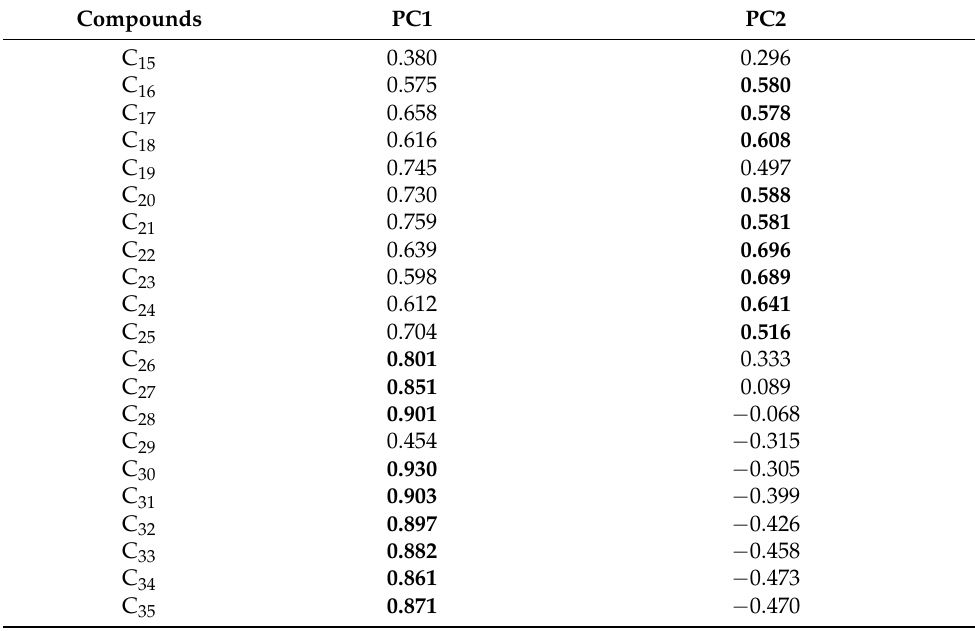
Table 6. Principal component analysis of n-alkanes in PM 2.5